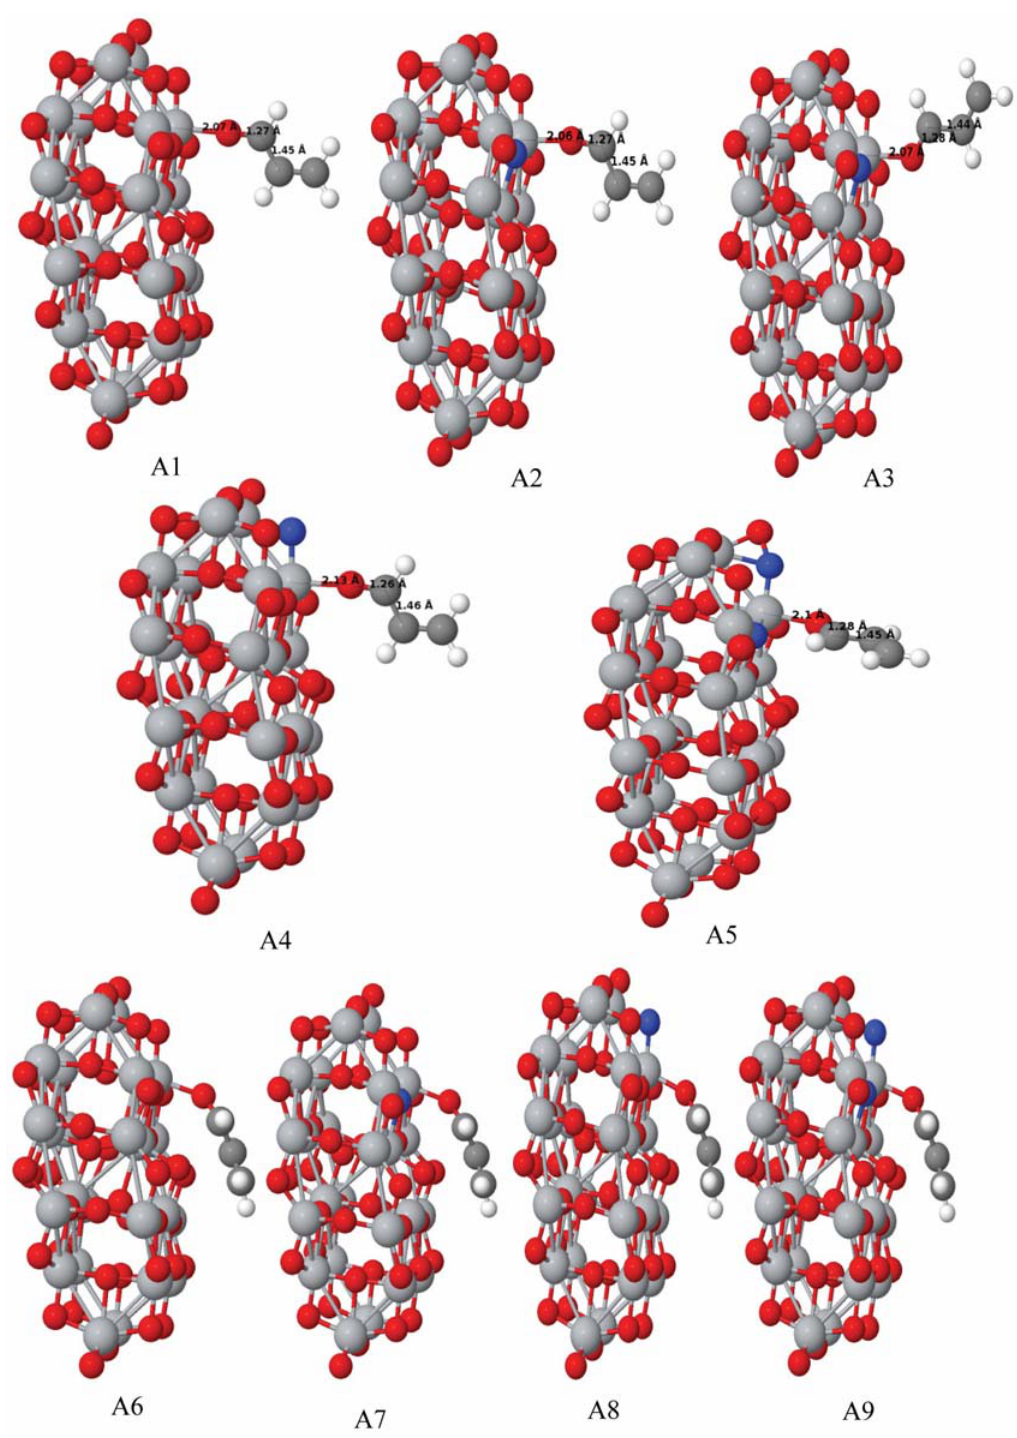
Fig. 3. Optimized geometry configurations of C in dark grey and H in